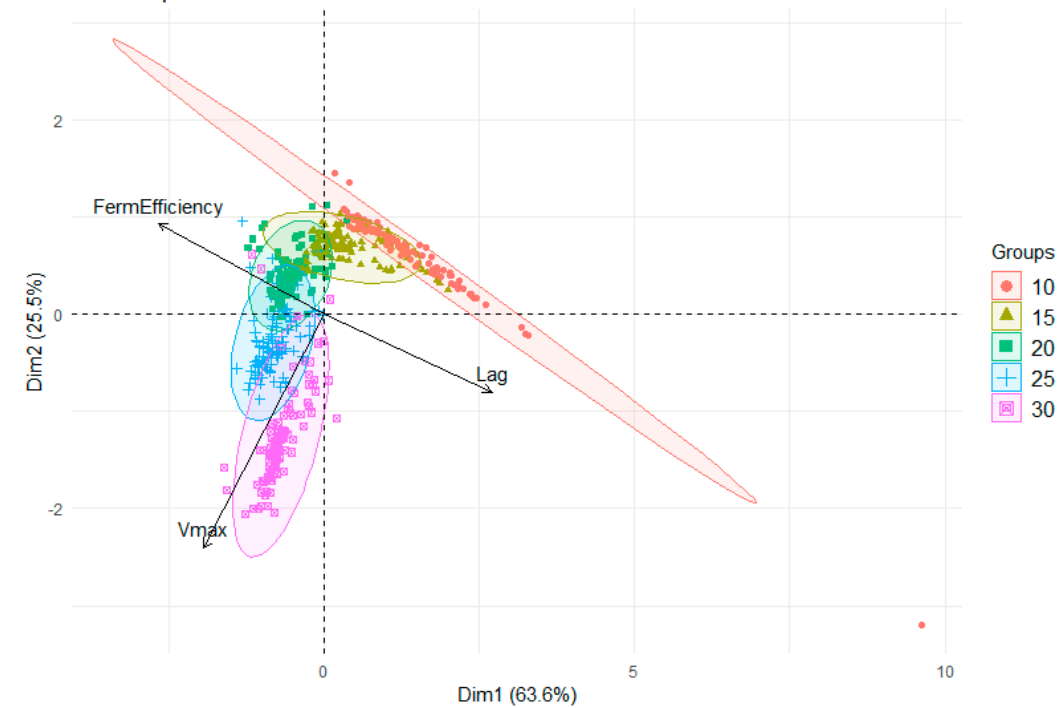
Figure 2. PCA biplot visualizing relationships between yeast strain genetic background, geographical origin, lifestyle, and temperature on lag time, V max, and fermentation efficiency across 34 S. cerevisiae strains. The 95% ellipsoids represent clusters based on temperature as the key variable with the following colors for each: 10°C (red), 15 °C (mustard), 20 °C (green), 25 °C (blue), and 30 °C (purple).